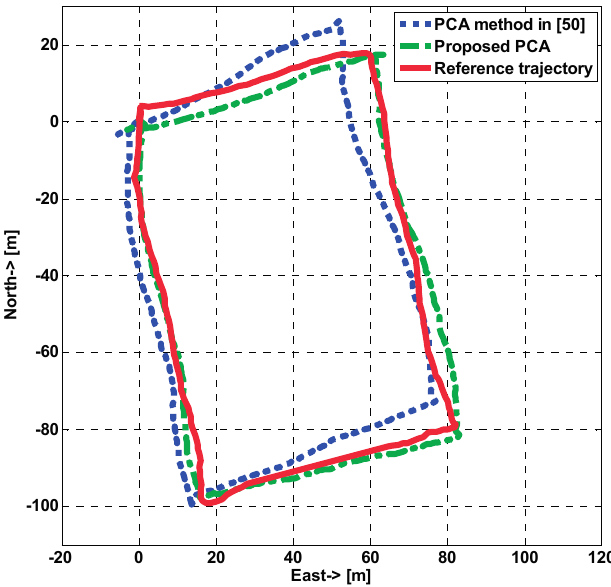
Figure 15. Estimated trajectories using different PCA